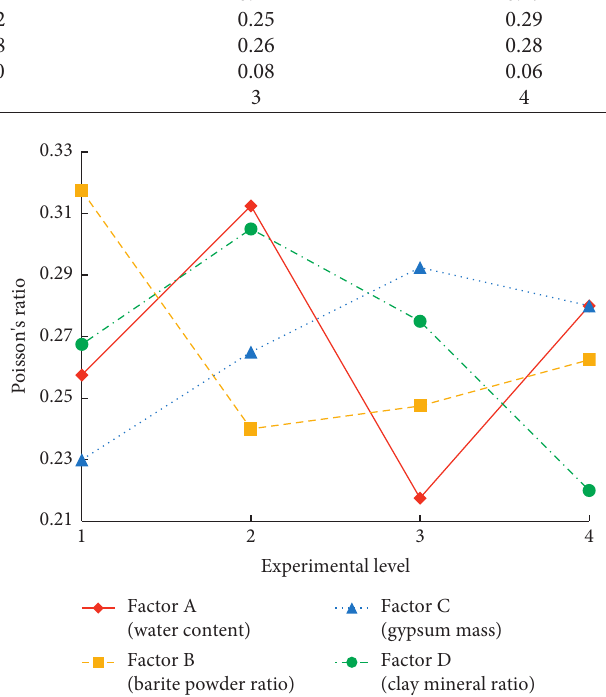
Figure 9: Range analysis of the factors affecting Poisson’s